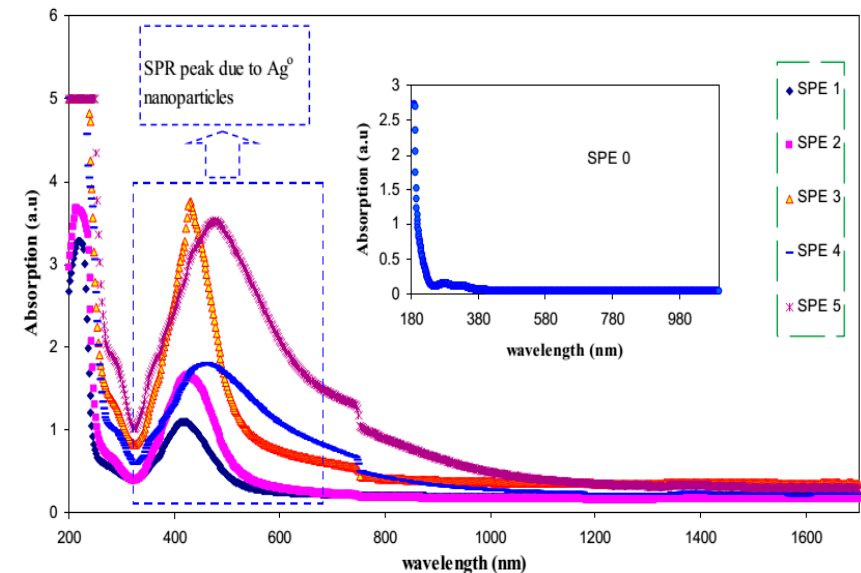
Figure 7. Absorption spectra of pure PVA (inset) and PVA/AgNt solid films. The SPR peak appearing at about 422 nm for PVA/AgNt samples is related to the existence of silver NPs [79].